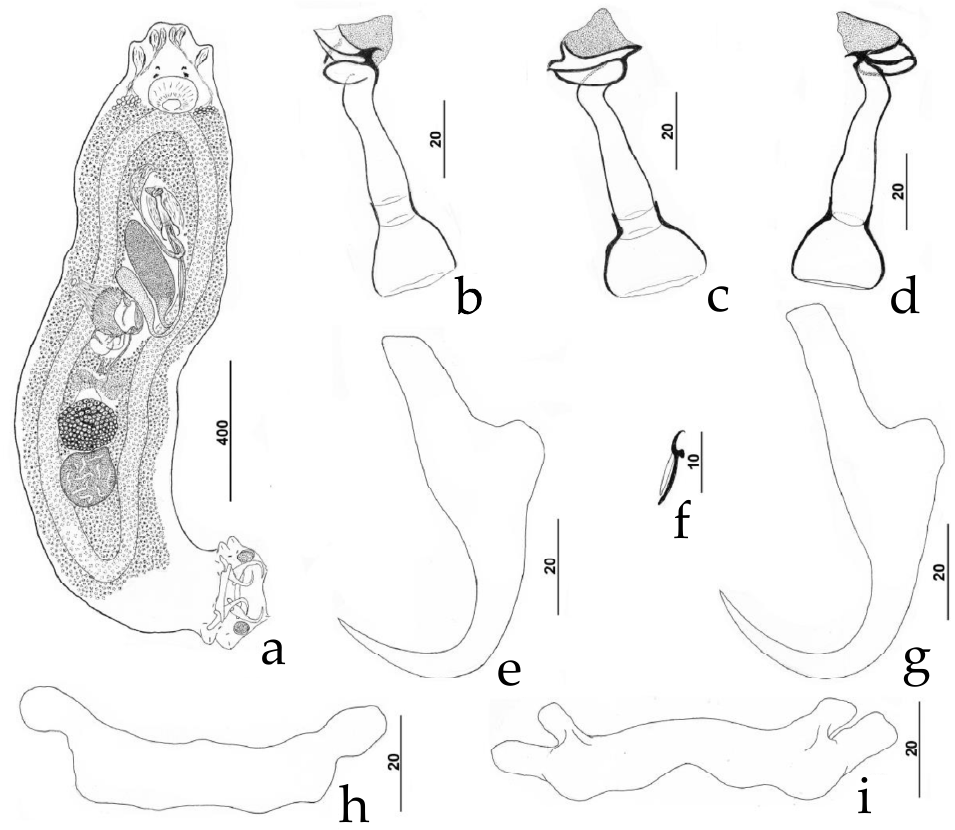
Figure 1. Platycephalotrema ogawai n. sp. ( a ) Whole mount (composite, ventral view); ( b–c ) male copulatory organs (ventral views); ( d ). male copulatory organ (dorsal view); ( e ) . dorsal anchor; ( f ) . hook; ( g ). ventral anchor; ( h ). ventral bar; ( i ). dorsal